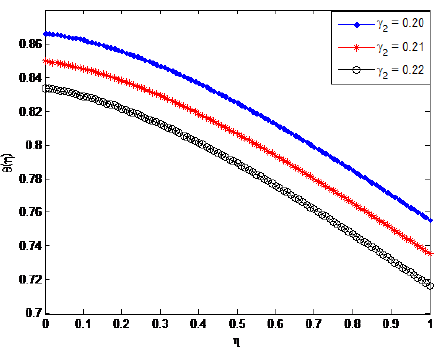
Figure 5. Influence of the second thermal Biot number on dimensionless temperature